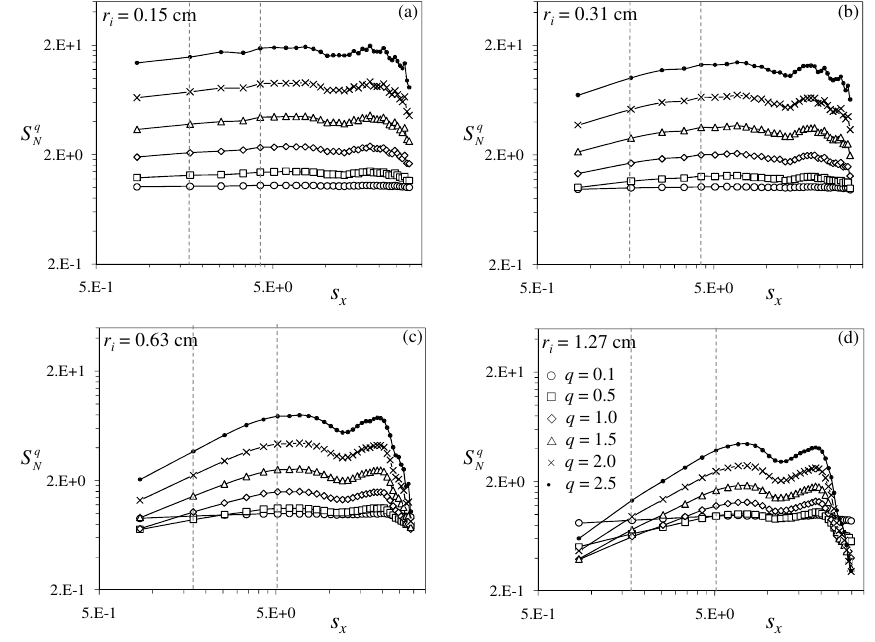
Fig. 4. Sample structure functions of absolute increments of various orders q versus lag along x direction on face 1 and (a) r i =0.15cm, (b) r i =0.31cm, (c) r i =0.63cm, (d) r i =1.27cm. Dashed vertical lines delineate ranges of lags within which power-law scaling is noted.